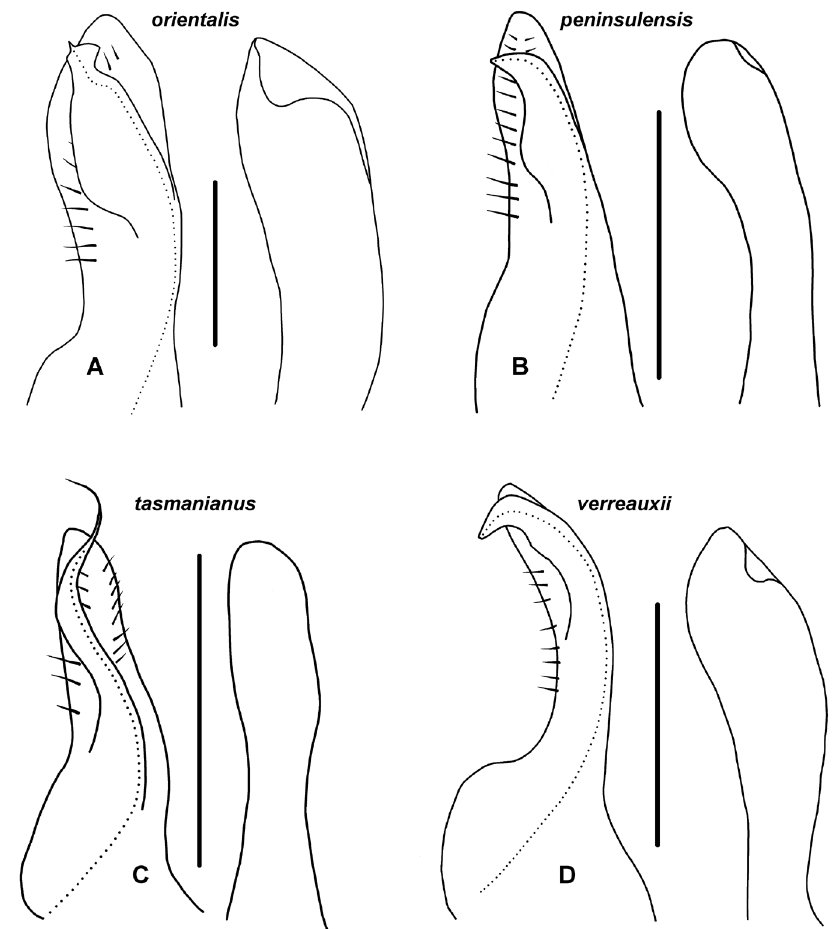
Figure 8. Right anterior gonopod, medial view of distal portion of telopodite (left) and lateral view of distal portion of coxite process (right); cxp = coxite process, fl = posterobasal flange on telopodite, pg = prostatic groove, ps = pseudoflagellum, t = folded-over tab on coxite process, te = telopodite. Scale bars = 1 mm; dotted line indicates course of prostatic groove. A Amastigogonus orientalis sp. n., paratype ex QVM 23:54401 B A. peninsulensis sp. n., QVM 23:54474 C A. tasmanianus Brölemann, 1913, ex QVM 23:54469 D A. verreauxii (Gervais, 1847), TMAG J5915. coxa. Prefemoral pad ca 1/2 femur length. Striae on posterior metazonites reaching 3/4 ozopore